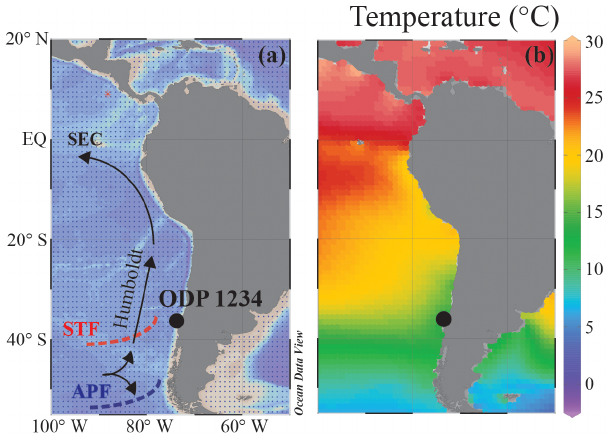
Figure 1. Maps showing the location of ODP Site 1234. (a) A simplified illustration of the present-day atmospheric and oceano- graphic setting and the site location. SEC: South Equatorial Current; APF: Antarctic Polar Front; STF: subtropical front. (b) Present- day mean annual SST ( ◦ C) for the region. Data derived from the World Ocean Atlas 2013 (Locarnini et al., 2013); maps were drawn in Ocean Data View (Schlitzer, 2015) and modified